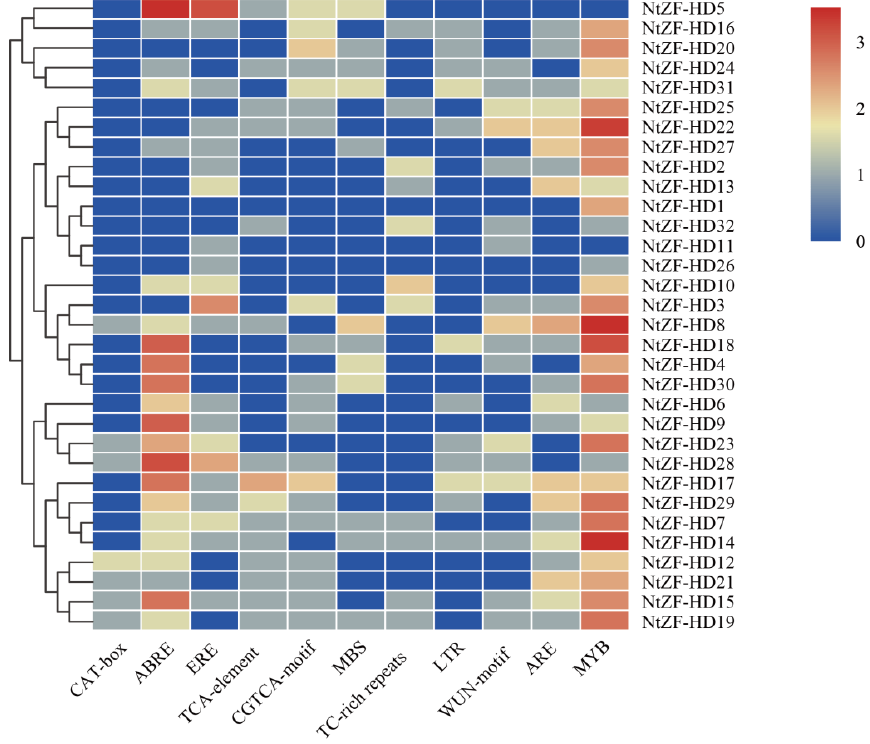
Figure 3. Statistics diagram of cis -elements in the promoter region of NtZF-HD genes. The colors represent the numbers of every cis -element in NtZF-HD family genes.